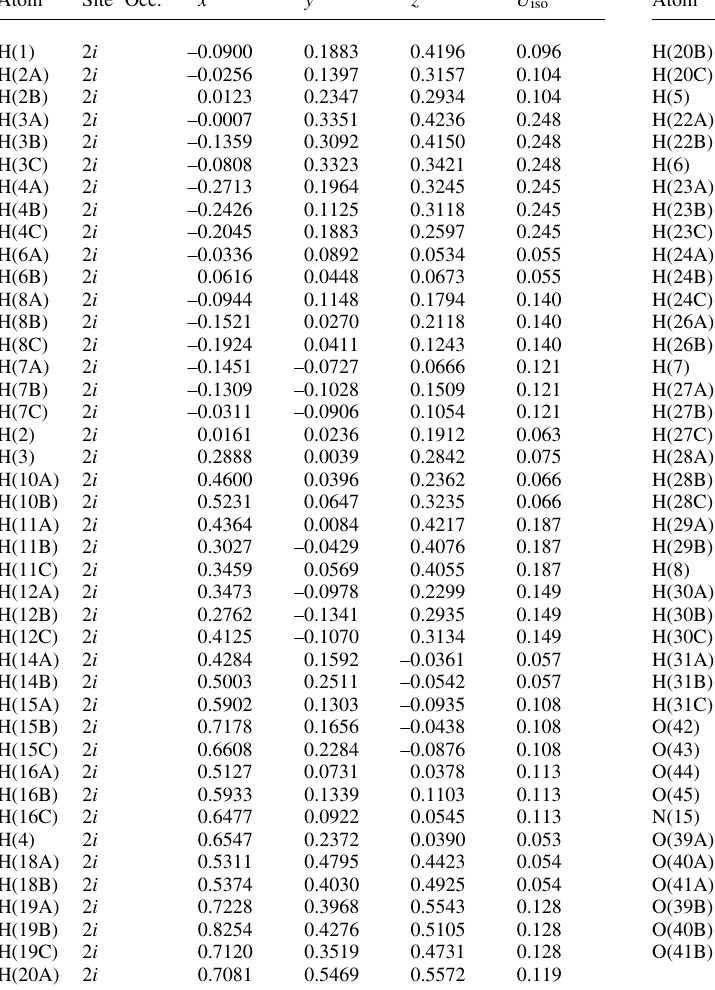
Table 2. Atomic coordinates and displacement parameters (in Å 2 ) . Atom Site